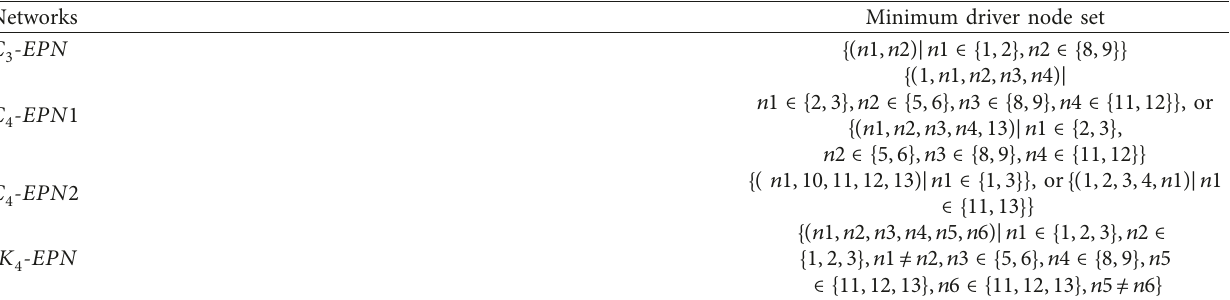
- EPN , C - EPN , and K 3 4